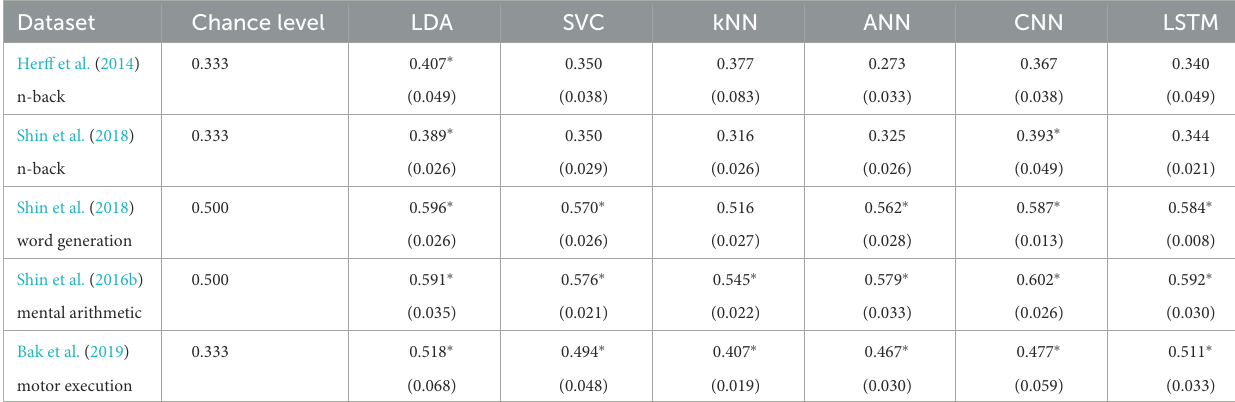
TABLE 2 Accuracies of the models on each dataset with the generalised approach.